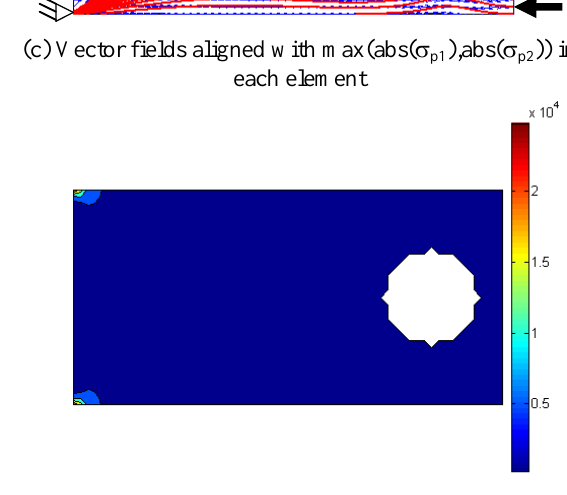
Fig. 26. nd distOrientation of load flow with a hole a buted loading